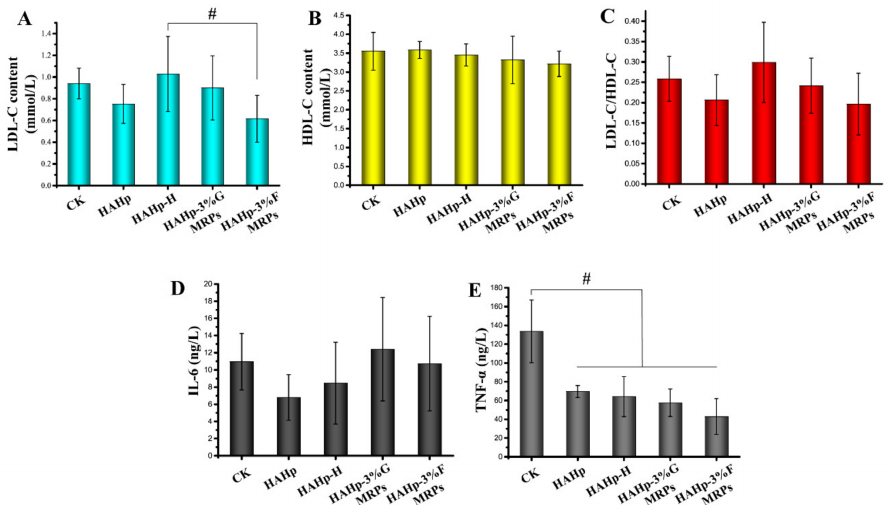
Figure 1. Effects of the oral administration of HAHp, HAHp-H, HAHp-3%G MRPs, and HAHp- 3%F MRPs on serum lipid metabolism and inflammatory factors in mice after 30 days compared to theCK group. ( A ) Low density lipoprotein cholesterol (LDL-C) content, ( B ) high density lipoprotein cholesterol (HDL-C) content, ( C ) LDL-C/HDL-C ratio, ( D ) inflammatory factors interleukin-6 (IL-6) concentration, and ( E ) tumor necrosis factor-alpha (TNF- α ) concentration. Results were expressed as the mean ± standard deviation ( n = 7), and # represented 0.01 < p <